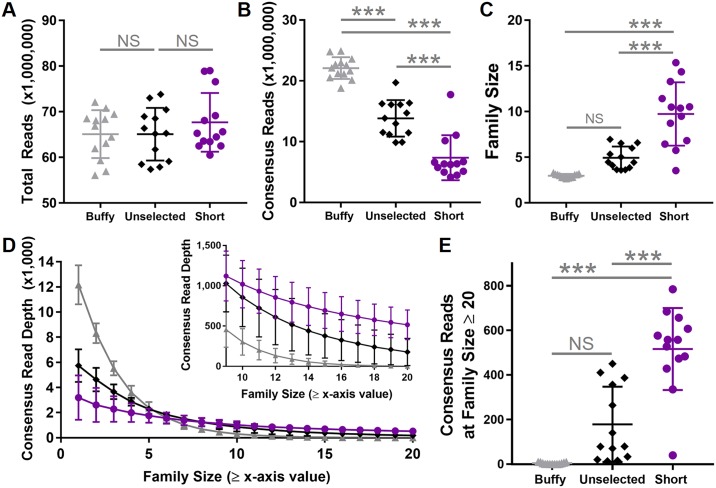
Generation of large family sizes in short ccfDNA.Total reads were similar between sheared buffy coat DNA, unselected ccfDNA, and short ccfDNA (A). Consensus read depth (family size ≥1) was greatest in buffy coat DNA, followed by unselected ccfDNA, and then short ccfDNA (B). Average family size was greatest in the short ccfDNA (C). At the specific variant locations for each patient, consensus read depth in buffy coat DNA rapidly decayed, reaching zero by family size ≥20 (D, gray). In contrast, both the unselected ccfDNA (D, black) and the short ccfDNA (D, purple) showed fewer consensus reads at family size ≥1, but maintained a greater read depth at larger family sizes (D, inset). Consensus read depth at family size ≥20 was greatest in short ccfDNA (E). In (A-C) and (E), solid bars represent the mean value. In (A-E), whiskers correspond to the standard deviation. *** P ≤ 0.001; NS = not significant.